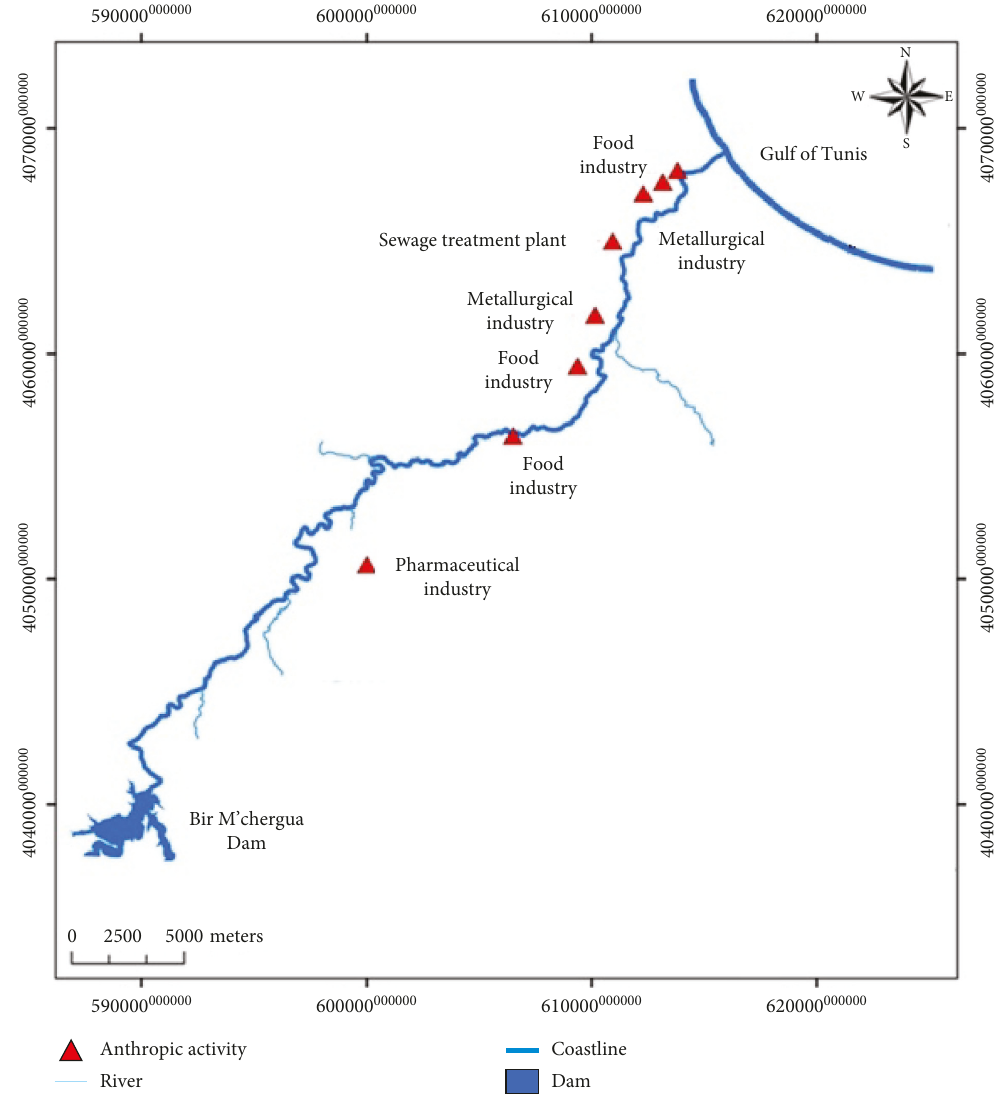
Figure 2: Location of several industries along the Meliane river. Table 1: Accuracy of heavy metal analysis (%). Table 2: Heavy metals sequential